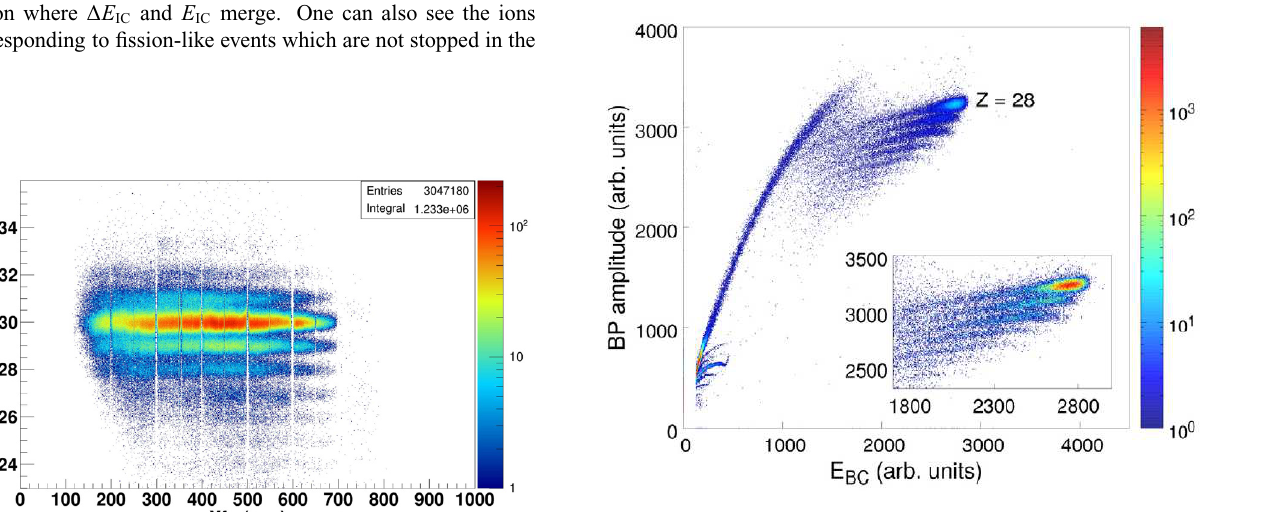
Figure 3. Two-dimensional scatter plots BP amplitude vs energy obtained for the reaction 58 Ni + 208 Pb at E lab ( 58 Ni) = 400 MeV and θ lab = 65 ◦ measured in the Bragg ionization chamber of the coincident detector (NOSE)